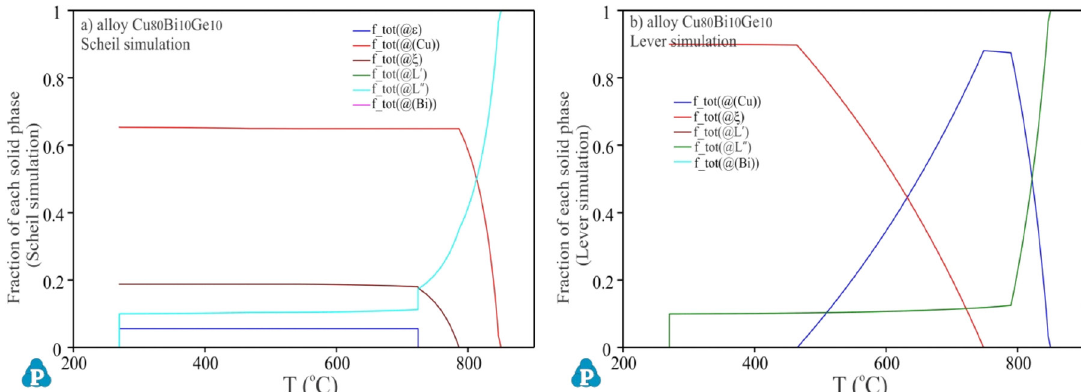
Figure 11. Fraction of each solid phase as a function of temperature for alloy Cu